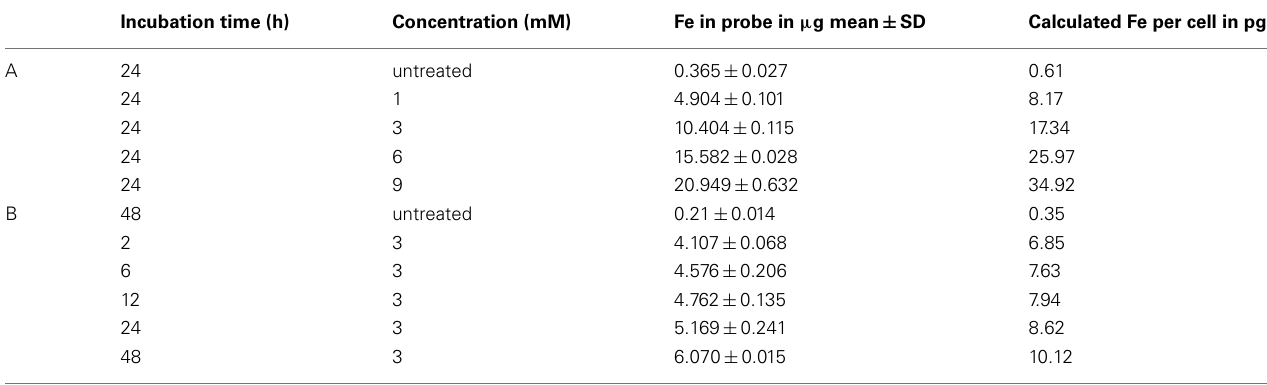
Table 1 | Iron uptake intoT cells after simple incubation withVSOP quantified with atomic absorption spectroscopy in probes containing 600000